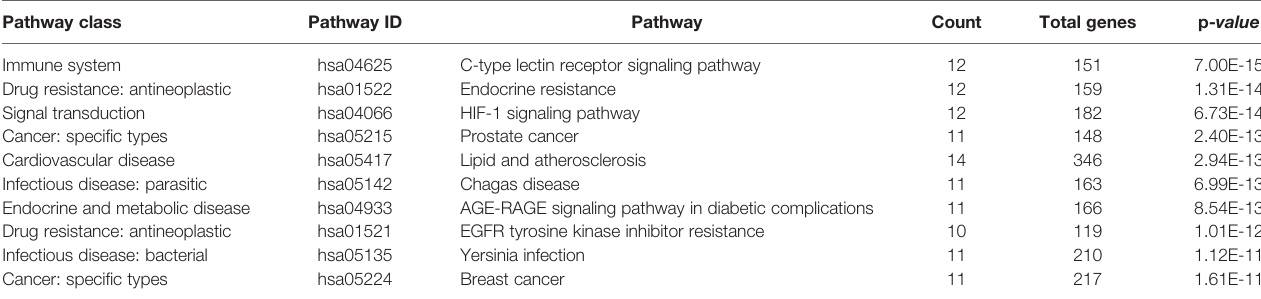
TABLE 1 | The KEGG pathway